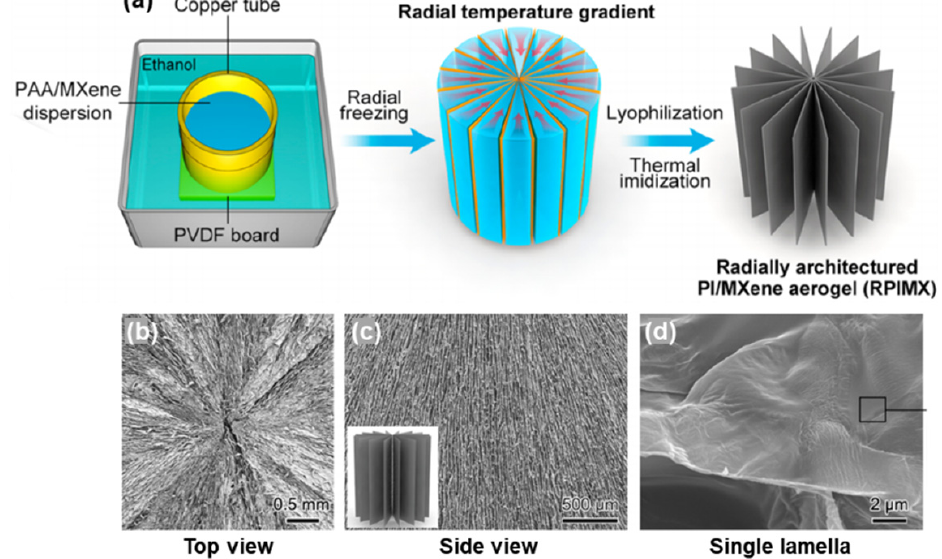
Figure 9. ( a ) Schematic illustration of RFC process and MXene/PI aerogel with radial lamellar structure. SEM images of the aerogel captured from the ( b ) top view and ( c ) side view, and ( d ) SEM image of a single lamella. Reproduced with permission from ref. [53]. Copyright 2022, American Chemical Society.